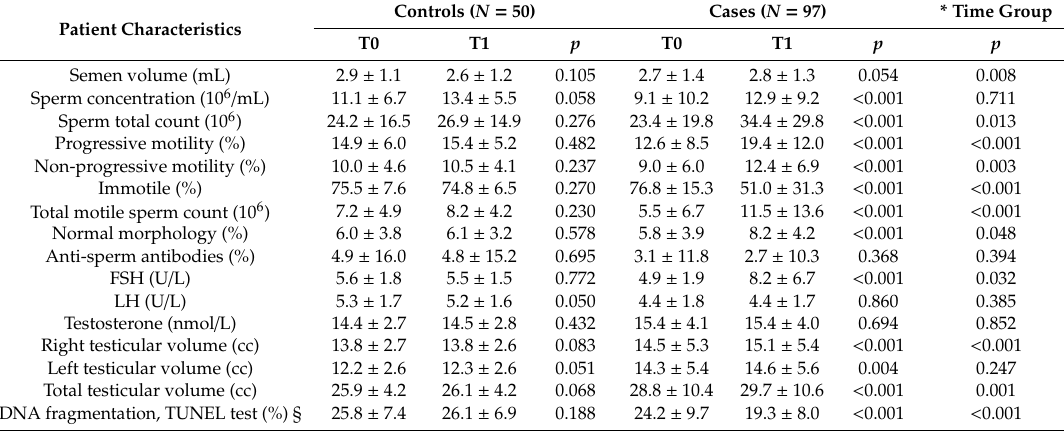
Table 1. Characteristics of treated (cases) and untreated patients (controls) observed at the start of the study (T0) and after 3 months (T1). * In the latter column the e ff ect of interaction time-by-group (T0–T1) is reported. § for DNA fragmentation TUNEL test: controls N = 50; cases N = 65. Patient